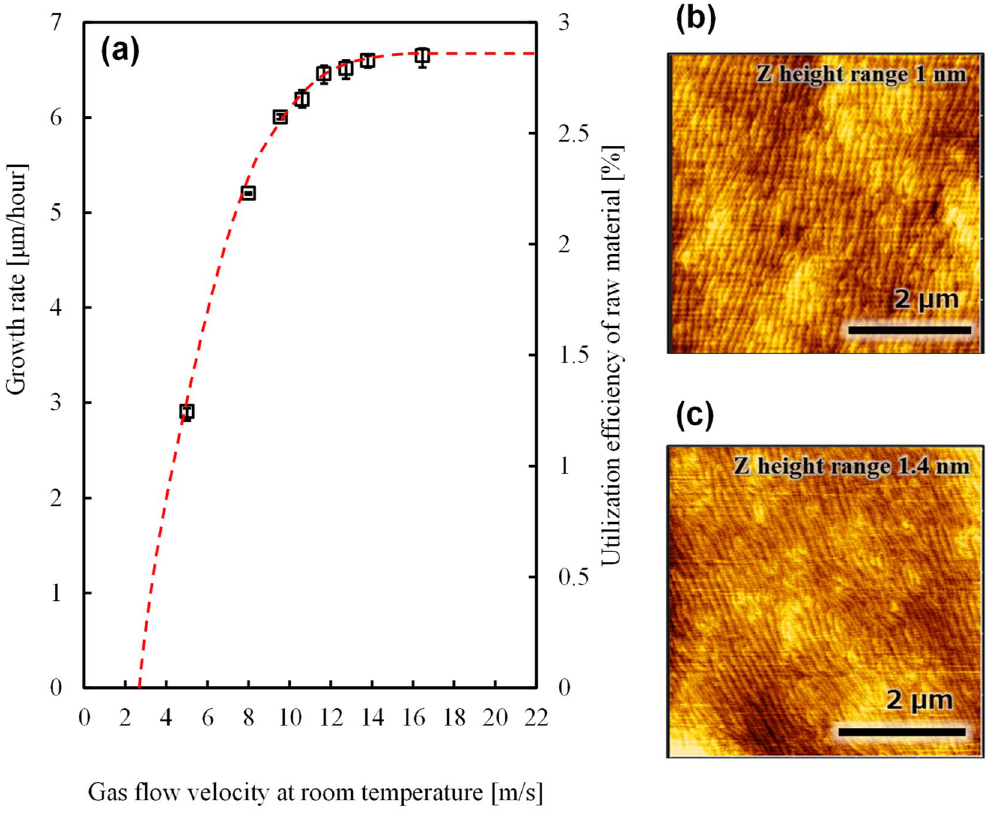
Figure 3. Effect of gas flow velocity. ( a ) The growth rate of AlN layer as a function of gas velocity calculated at room temperature. The adduct formation and polymerization decreased the amount of raw material used for the growth at flow rates below 10 m/s; ( b ) Atomic force microscope (AFM) images of AlN film grown at a gas flow velocity of 10 m/s. The growth rate in the experiment was approximately 20% lower under these conditions compared to the values presented in ( a ); ( c ) AFM images of AlN surface grown at a gas flow velocity of 16.5 m/s.